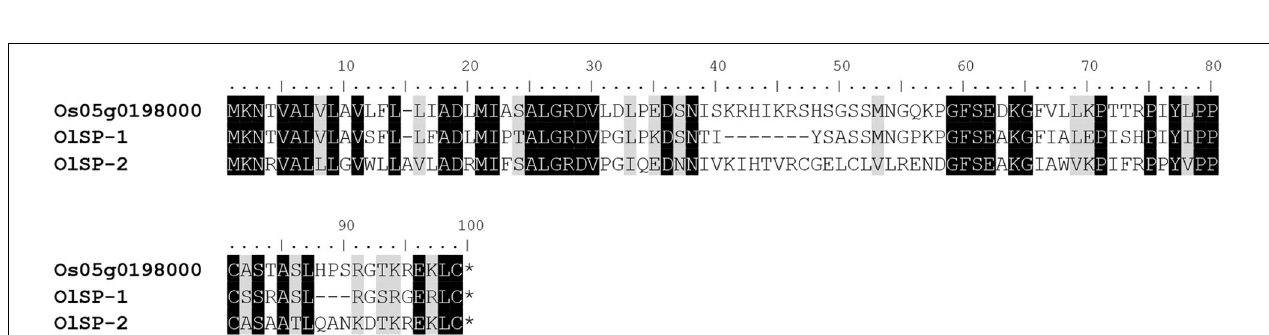
FIGURE 4 | Amino acid sequence polymorphism of OlSP. OlSP-1 and OlSP-2 are the amino acid sequences encoded by the two alleles of OlSP in Oryza longistaminata . The sequence similarity between OlSP-1 and OlSP-2 and Os05g0198000 is 51.8 and 63.2%, respectively.